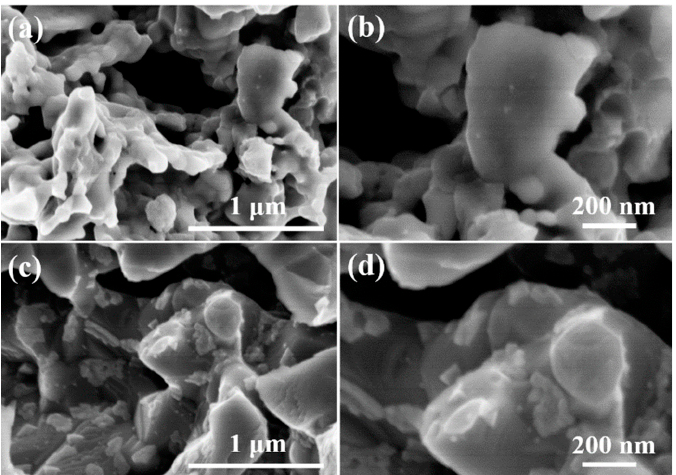
Figure 6. FE-SEM images of the oxygen electrodes after 10% H 2 O-Ar treatment at 750 °C for 5 h: ( a , b ) SSNC; ( c , d )